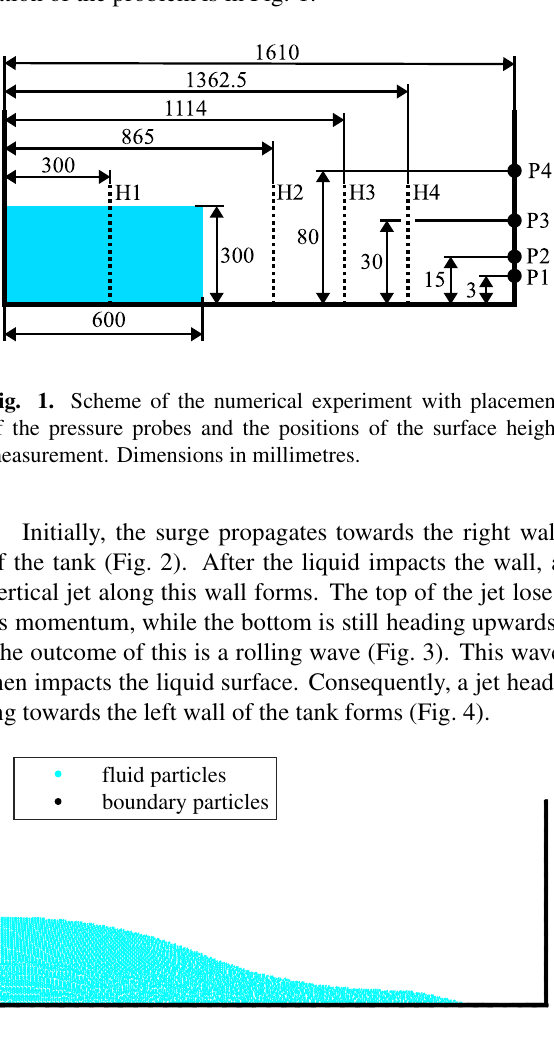
Fig. 2. Initial surge propagation. T = 2 . 0